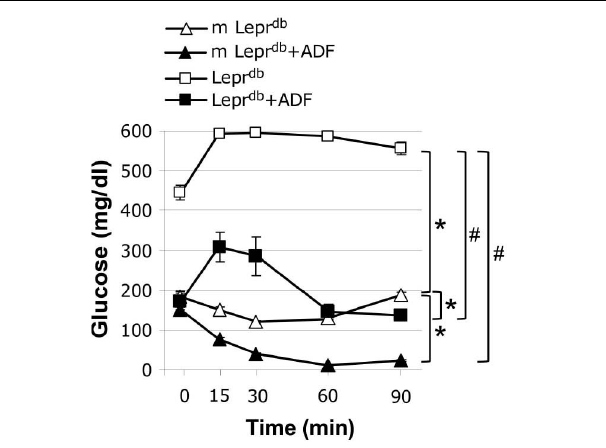
FIGURE 1 | Alternate day fasting (ADF) improved insulin sensitivity in both m Lepr db and Lepr db mice. Insulin tolerance tests revealed that diabetic mice ( Lepr db ) had impaired glucose metabolism compared with control mice ( m Lepr db ). Twelve weeks of alternate-day fasting (ADF) improved insulin sensitivity in both Lepr db and m Lepr db mice. Data represent mean ± SEM. n = 6 m Lepr db , 6 m Lepr db + ADF, 6 Lepr db , and 5 Lepr db + ADF. * P < 0.05 vs. m Lepr db control mice, # p < 0.05 vs. Lepr db diabetic